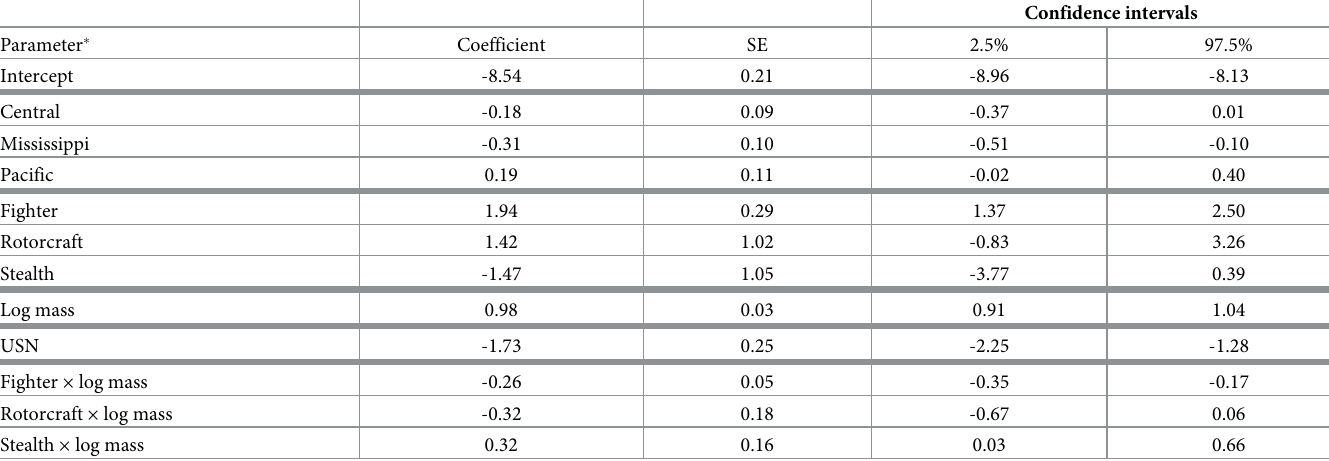
Table 4. Binary logistic regression models predicting substantial damage to Navy (USN) and Air Force (USAF) within the United States. This model represents the best as evaluated by the lowest Akaike’s Information Criterion (AIC) value (see S8 Table for other candidate models). McFadden’s r 2 value is 0.23. Predictor variables include flyway (Central, Mississippi, Pacific, Atlantic), airframe (cargo, rotorcraft, stealth, fighter), avian log body mass, military branch, and the airframe × avian log body mass interaction.